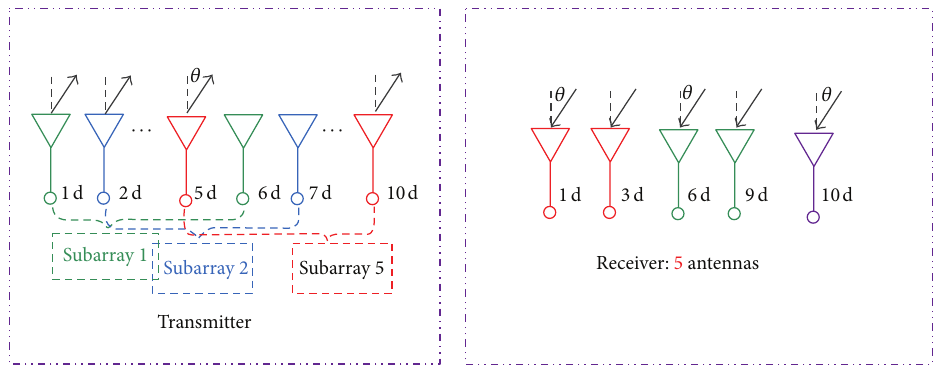
Figure 7: Alternative receiving array with 5 elements for joint phased-array and nested-array.